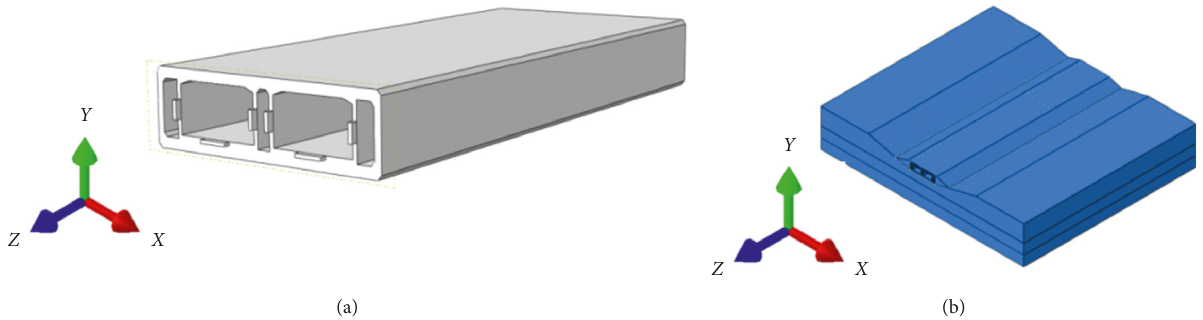
Figure 5: Pipe model and overall model. (a) A single pipe model; (b) overall